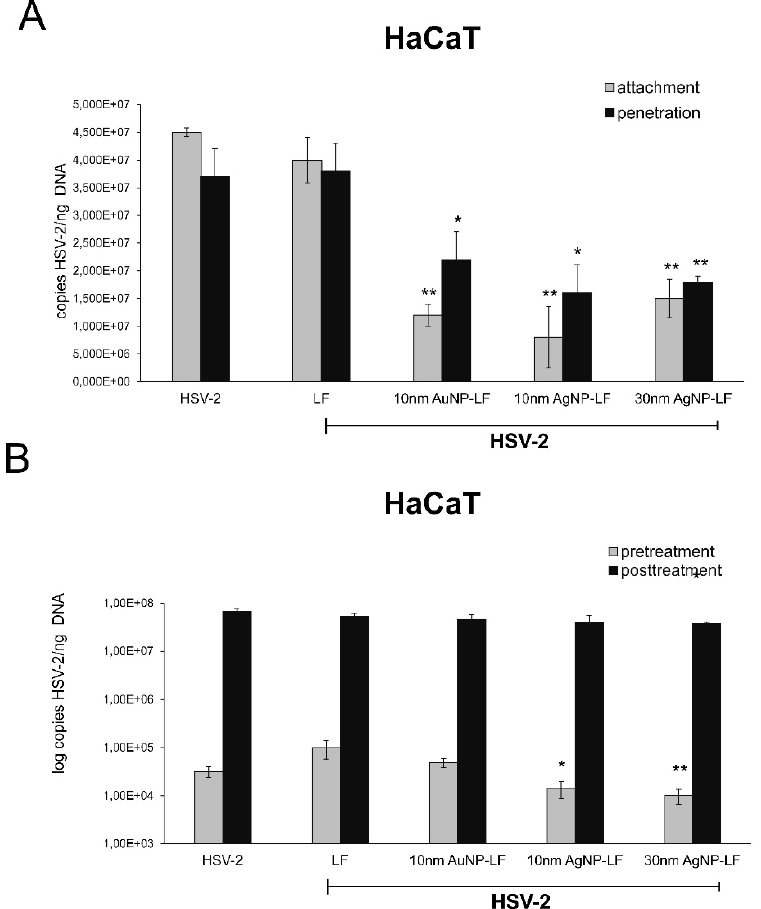
Figure 4. Lactoferrin-modified Ag/AuNPs block HSV-2 attachment and penetration in skin HaCaT keratinocytes. ( A ) Inhibition of virus attachment and penetration in HaCaT cell cultures with the use of 10 nm LF-Ag/AuNPs, 30 nm LF-AgNPs or lactoferrin. At 24 h p.i. cells were subjected to HSV-2 copies titration by qPCR. ( B ) efficiency of pre- or posttreatment with 10 nm LF-Ag/AuNPs, 30 nm LF-AgNPs or lactoferrin was tested 6 h pre- or post-infection. At 24 h p.i. cells were subjected to HSV-2 copies titration by qPCR. In all experiments, lactoferrin in concentration corresponding to the amount used to modify NPs served as positive control. The data are expressed as means from three independent experiments ± SEM. * represents significant differences with p ≤ 0.05, ** p ≤ 0.01 in comparison to untreated infected control (Student t test).